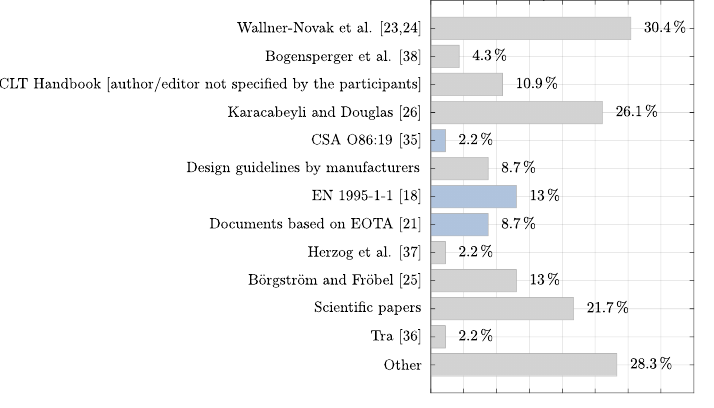
Figure 7. Used literature for design.